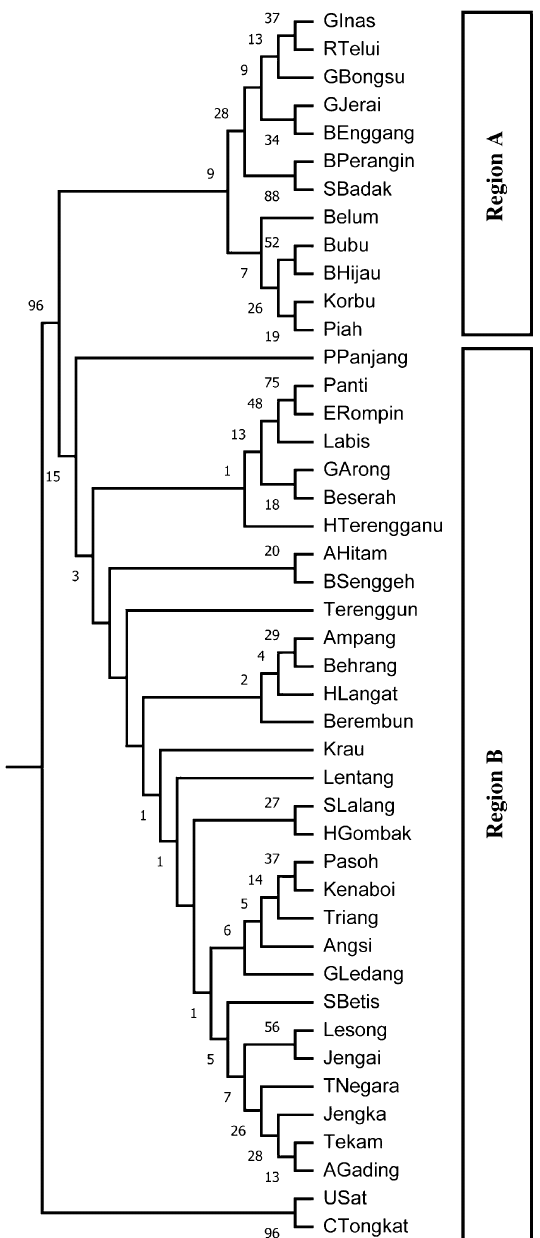
Figure 2. Dendrogram showing the relationship between 44 populations of Shorea leprosula in Peninsular Malaysia based on the UPGMA cluster analysis of SSR